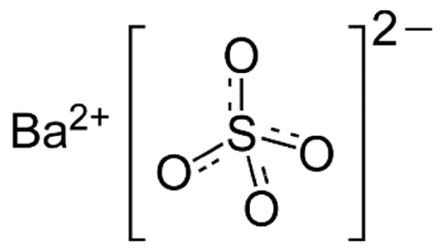
Figure 1. Chemical structure of barium sulfate.